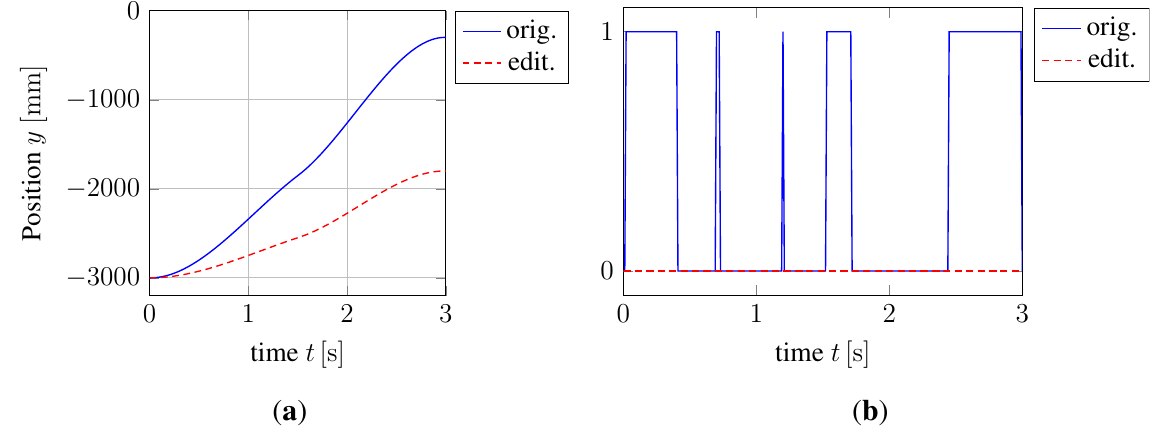
Figure 12. Demonstration of the functionality of the path verification results with a second test trajectory. ( a ) Cartesian coordinate y in mm of the original and edited curve; ( b ) path verification results of original and edited curve (0, no test failed; 1, cable acceleration test